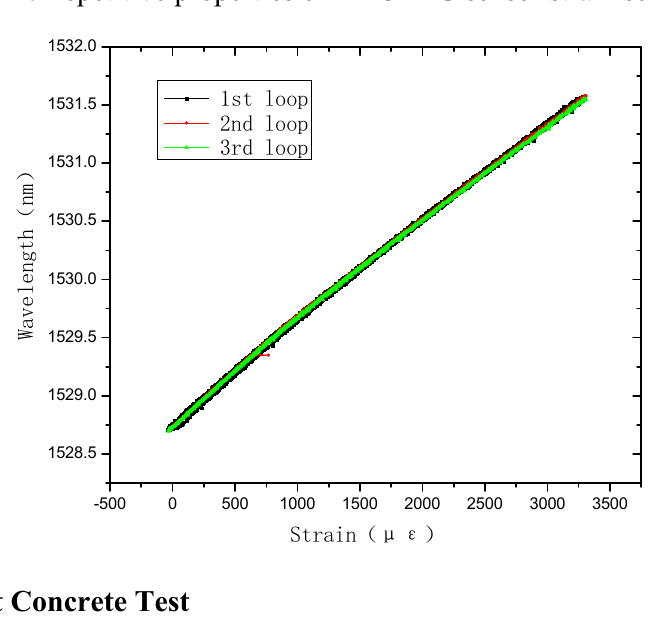
Figure 12. Repetitive properties of PP-OFBG sensor strain